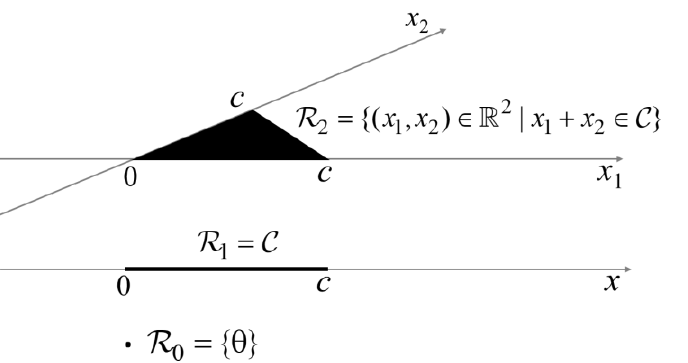
S n of a stochastic list with M = 1, L = 2 and the constraint set Figure 1. The state space S = ∪ L 0 L C = { x ∈ R | 0 ≤ x ≤ c } is shown in black. Symbol θ denotes the empty list. = S S of a stochastic list with 1 M = , 2 L = and the constraint set Figure 1. The state space n 0 { | 0 } x x c =    is shown in black. Symbol  denotes the empty list. ( t )) on the state space S is called a A stochastic process Y ( t ) = ( ζ 1 ( t ) , . . . , ζ n ( t ) A stochastic process 1 ( ) ( ) ( ( ),..., ( )) t Y t ζ n